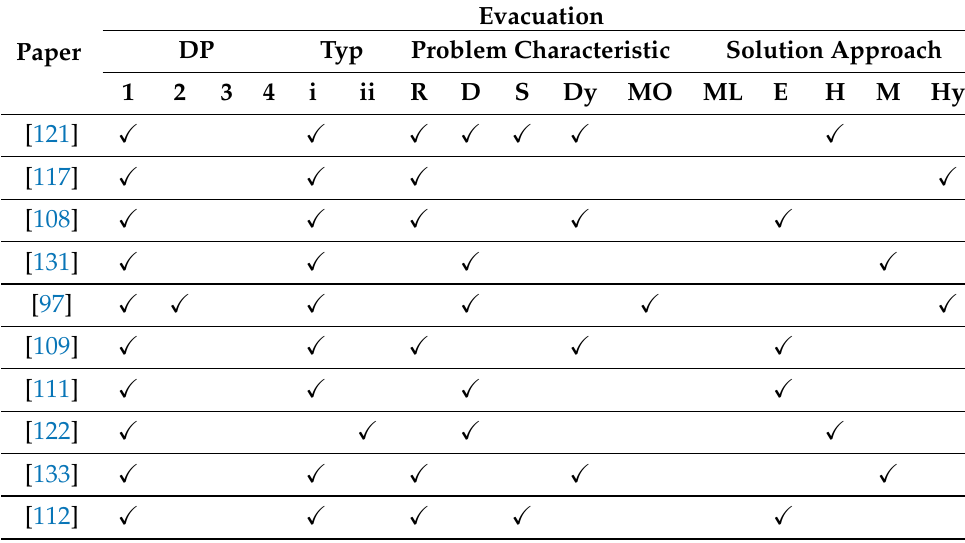
Table A5. VRPs for Evacuation in Humanitarian Logistics.